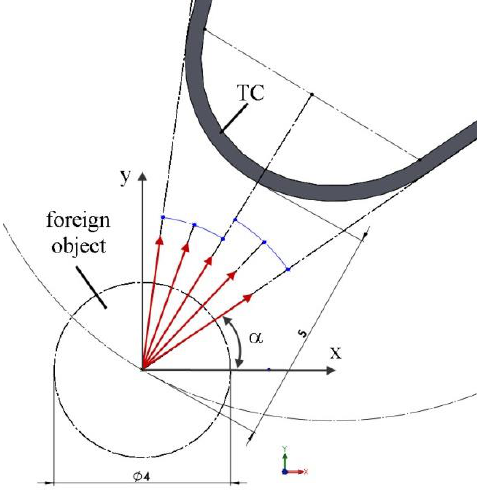
Figure 8. Angles of foreign object incidence.